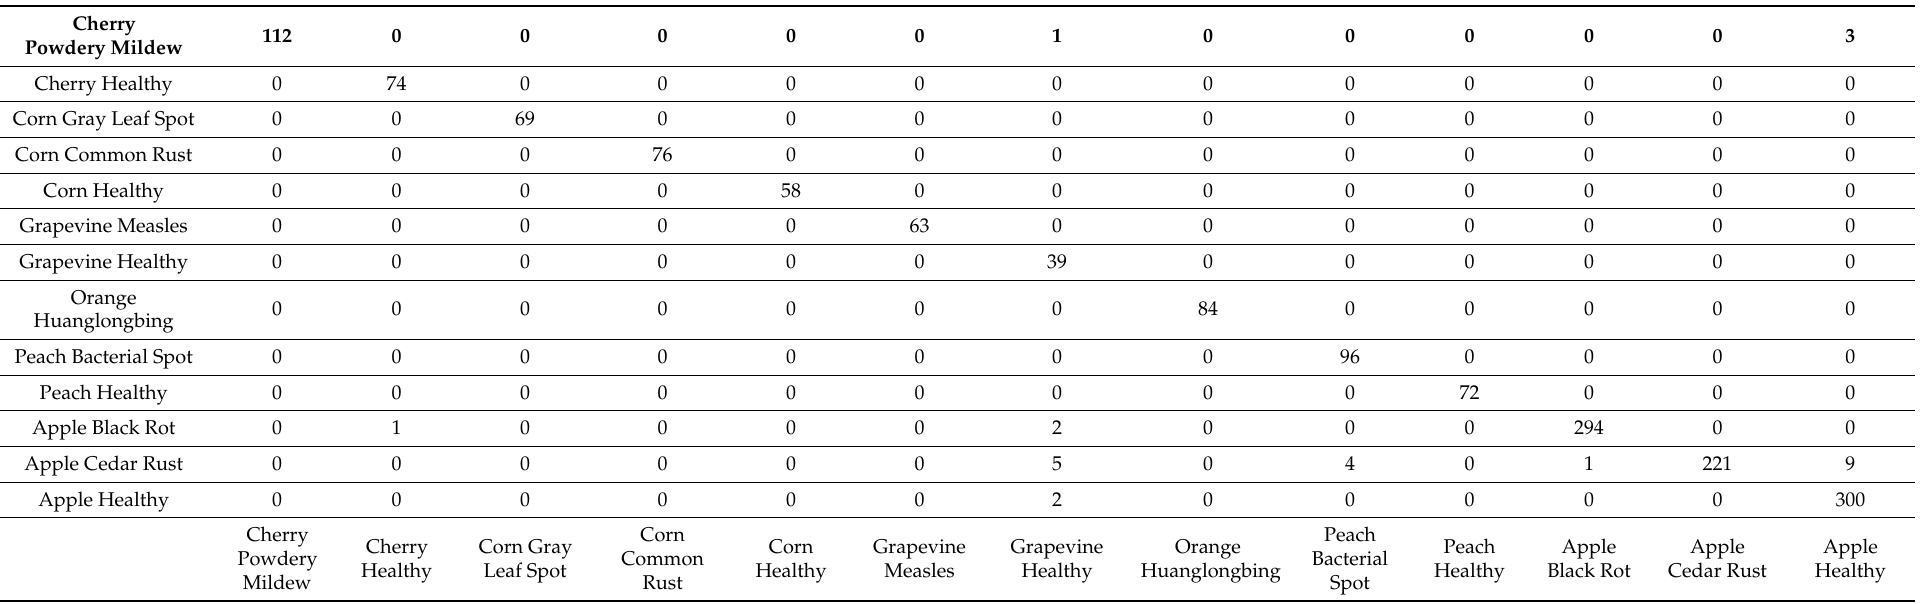
Table 7. Confusion matrix of 13